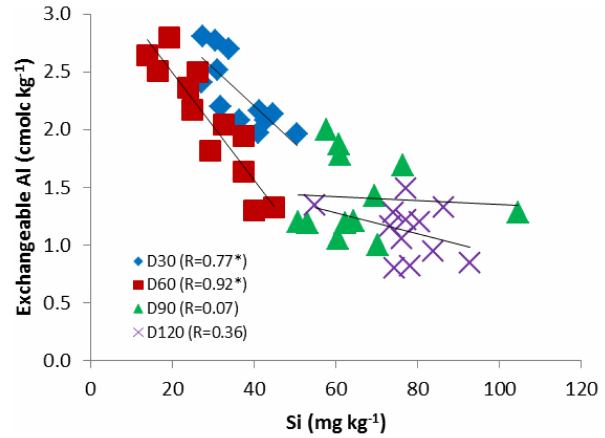
Figure 7. Relationship between exchangeable Al and Si content in the soil throughout the incubation period ( ∗ p< 0 . 05).